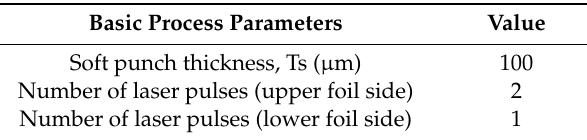
Table 6. Determined basic process parameters.